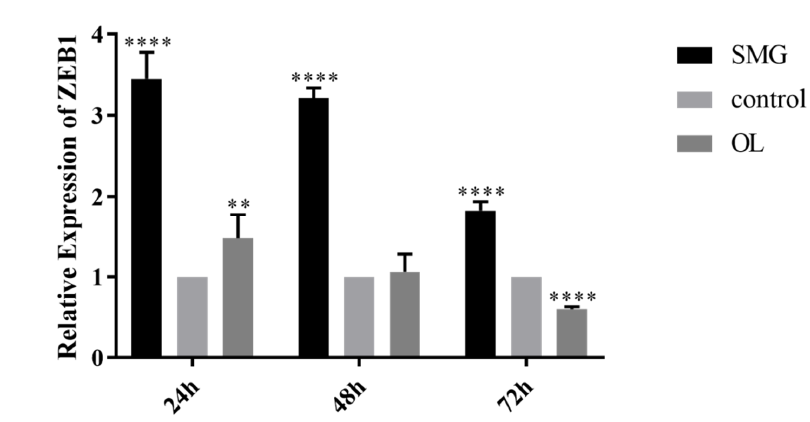
Figure 13. The mRNA expression changes of Snail ( A ), Twist ( B ), and ZEB1 ( C ) in MCF-7 cells were detected by qRT-PCR. The statistical results shown represent the means ± SD ( n = 3). Significant difference; ** p < 0.01and **** p < 0.0001, extremely significant.